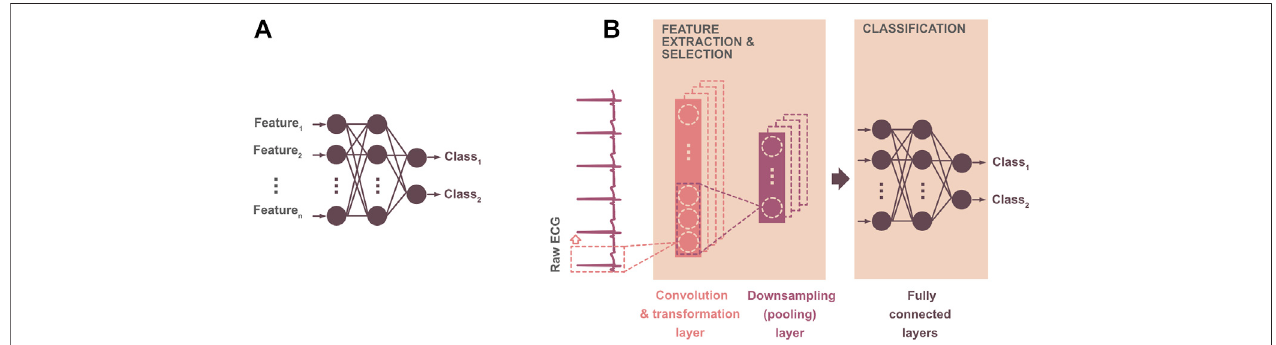
FIGURE4| Illustrationoftwobinaryclassi fi cationmodels: (A) straightforwardarti fi cialneuralnetwork — machinelearningmodelprovidingECGclassi fi cationbased on the previously derived features; (B) 1D convolutional neural network (1DCNN) — deep learning model providing automatic extraction ofthefeaturesfrom raw ECG by convolutional layer(s) and further assignment of the input into the class by fully connected perceptron-like layers. In a 1D CNN model, the convolutional layer consists of fi lters, which derive important features from the input ECG. The convolution output — feature map — is usually transformed using a linear or non-linear function (in ordertosimplifythetrainingprocessandavoidtheproblemofvanishinggradient)anddownsampledbycalculatingtheaverage(averagepooling)orbyselectingmaximal (max-pooling) values from the feature map. The pooling procedure leads to the reduced number of model parameters and, thus, decreased computation